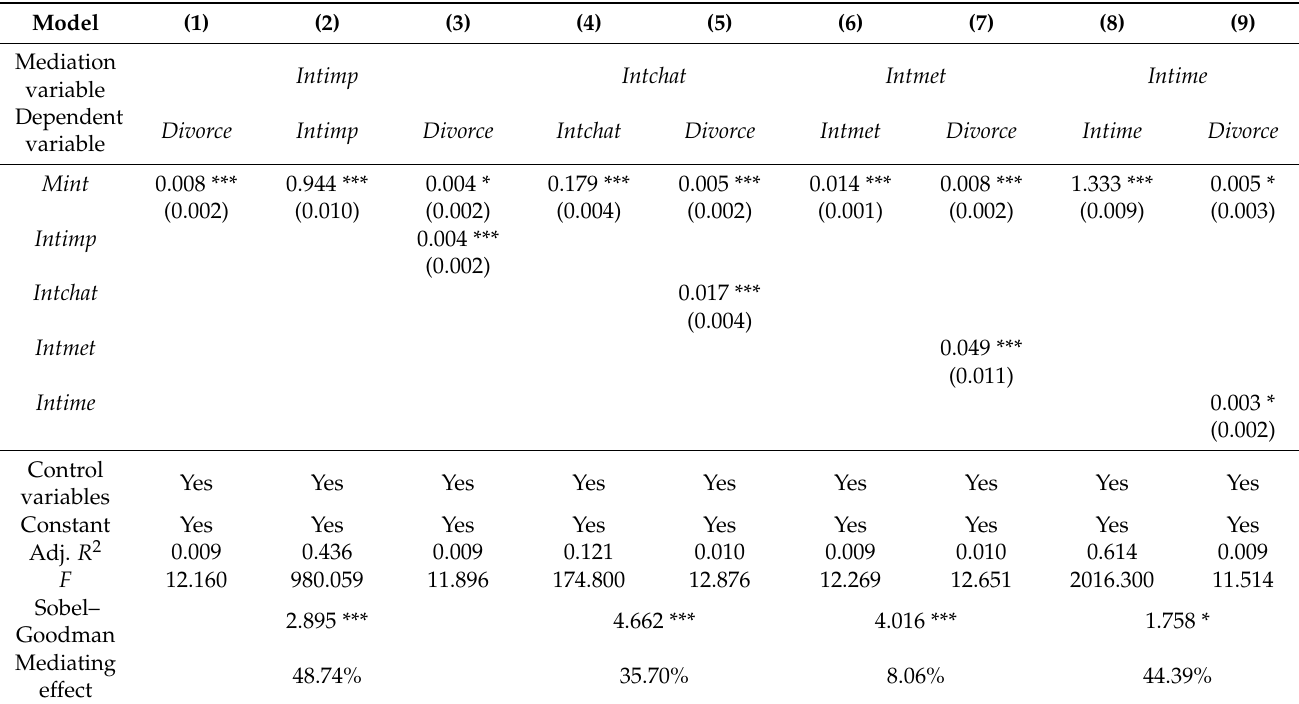
Table 7. Mediation effect results of Internet use on divorce risk ( N =